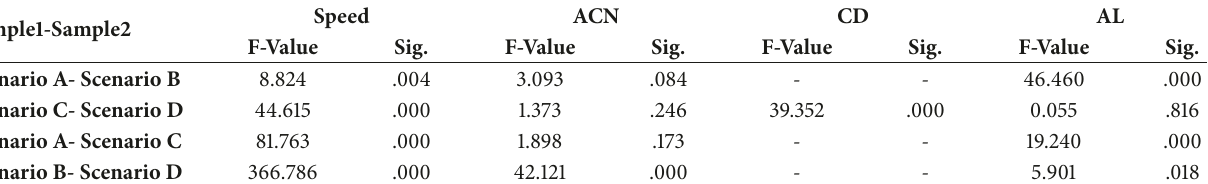
Table 3: Significance testing of driving behaviors in different scenarios.